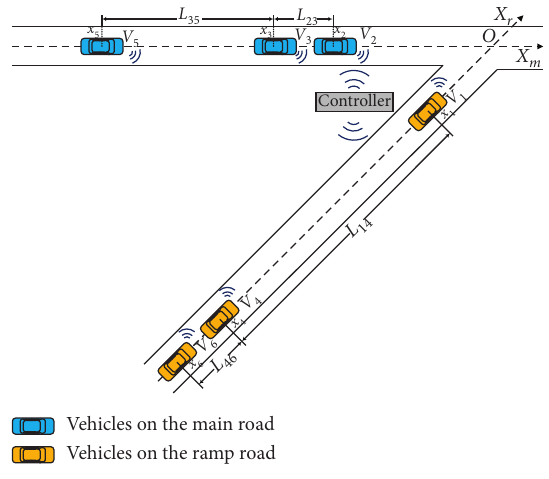
Figure 2: Scenario illustrating Rule 3